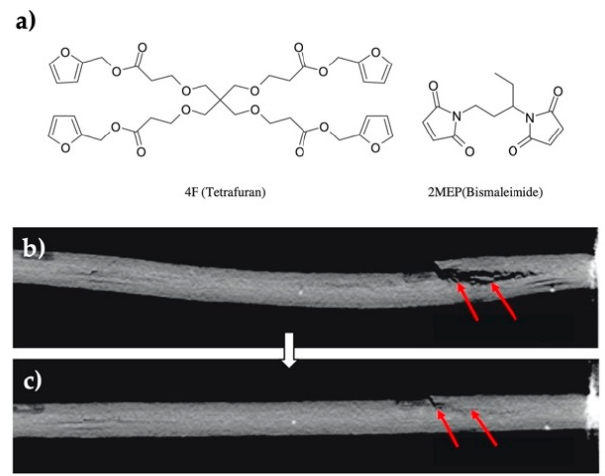
Figure 5. ( a ) Chemical structures of monomers used to make 2MEP4F, ( b ) section views of sample 1